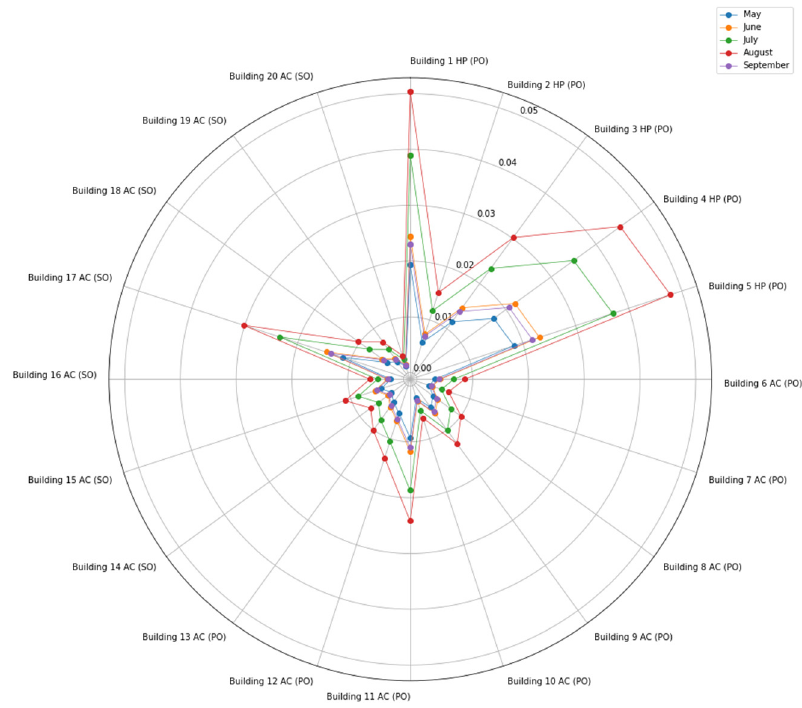
Energies 2022 , 15 , x FOR PEER REVIEW Figure 15. Energy savings obtained on an average day for cooling. Figure 15. Energy savings obtained on an average day for cooling.